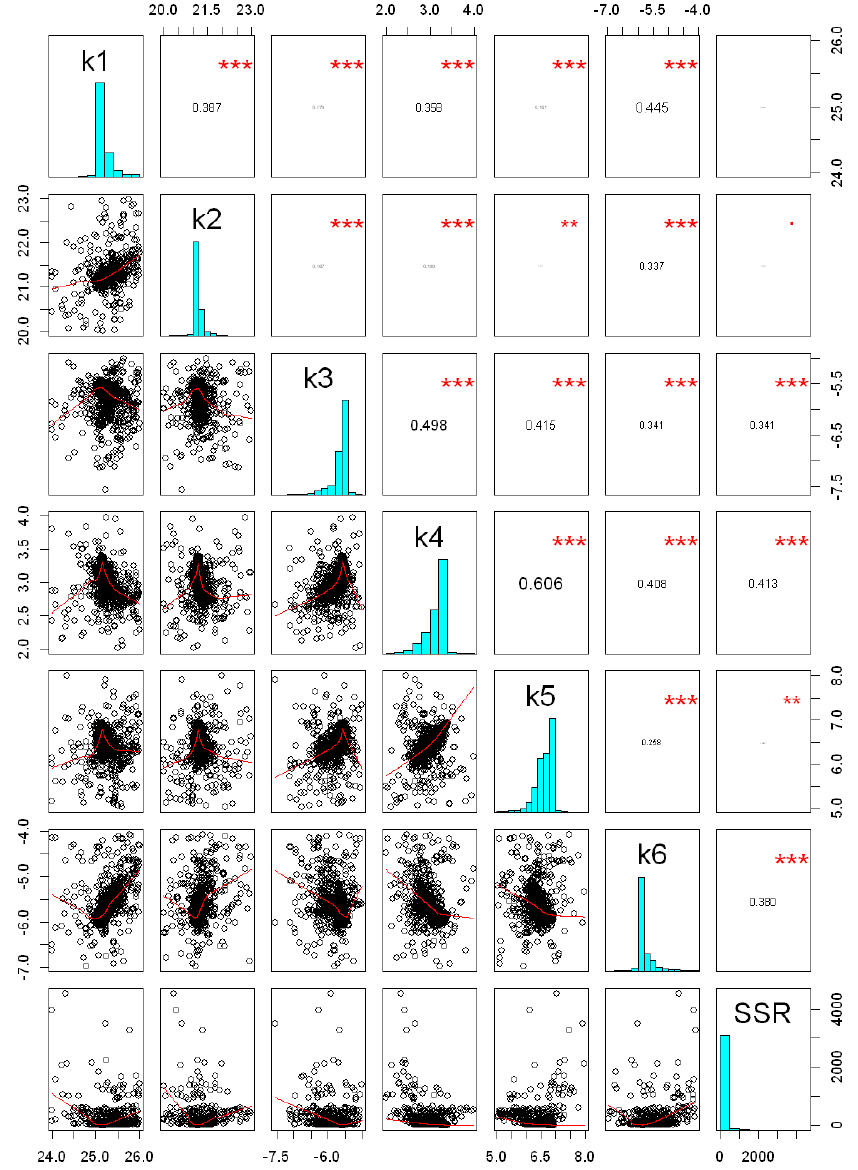
Figure 8. Correlation matrix between model performance (SSR) and calibrated parameters. Red lines represent lowest smoothing, using locally weighted polynomial regression, and numbers in the upper panel represents the Pearson-moment correlation coefficient between each pair of parameters. Vertical and horizontal axes illustrate the physical range utilized for parameter optimization. ∗∗∗ stands for a p < 0 . 001; ∗∗ stands for p < 0 . 01, according to level of statistical significance